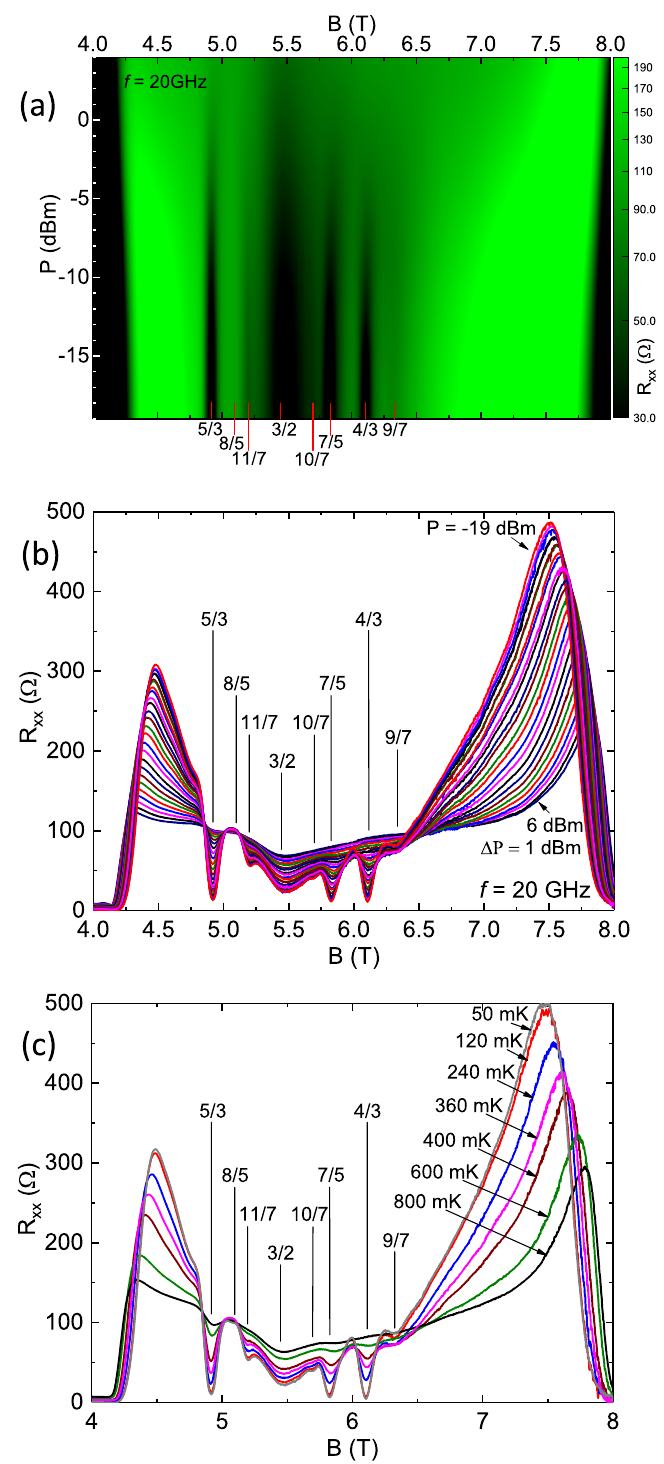
Figure 2. Microwave power (( a ),( b )) and temperature ( c ) evolution of the diagonal resistance R xx between 4 ≤ B ≤ 8 T ( 1 < ν < 2 ). ( a ) Color plot of R xx vs. B and vs. P at f = 20 GHz . P is specified in dBm (decibel - milliwatts) ( b ) R xx vs. B is plotted at various microwave power P between − 19 ≤ P ≤ 6 dBm in steps (cid:31) P = 1 dBm . Some filling factors of interest are marked with vertical lines. ( c ) R xx vs. B is plotted at temperatures 50 ≤ T ≤ 800 mK . Some filling factors of interest are marked with vertical lines. Note the absence of a resistance minimum or maximum, or temperature sensitivity, at ν = 8 / 5 in all three